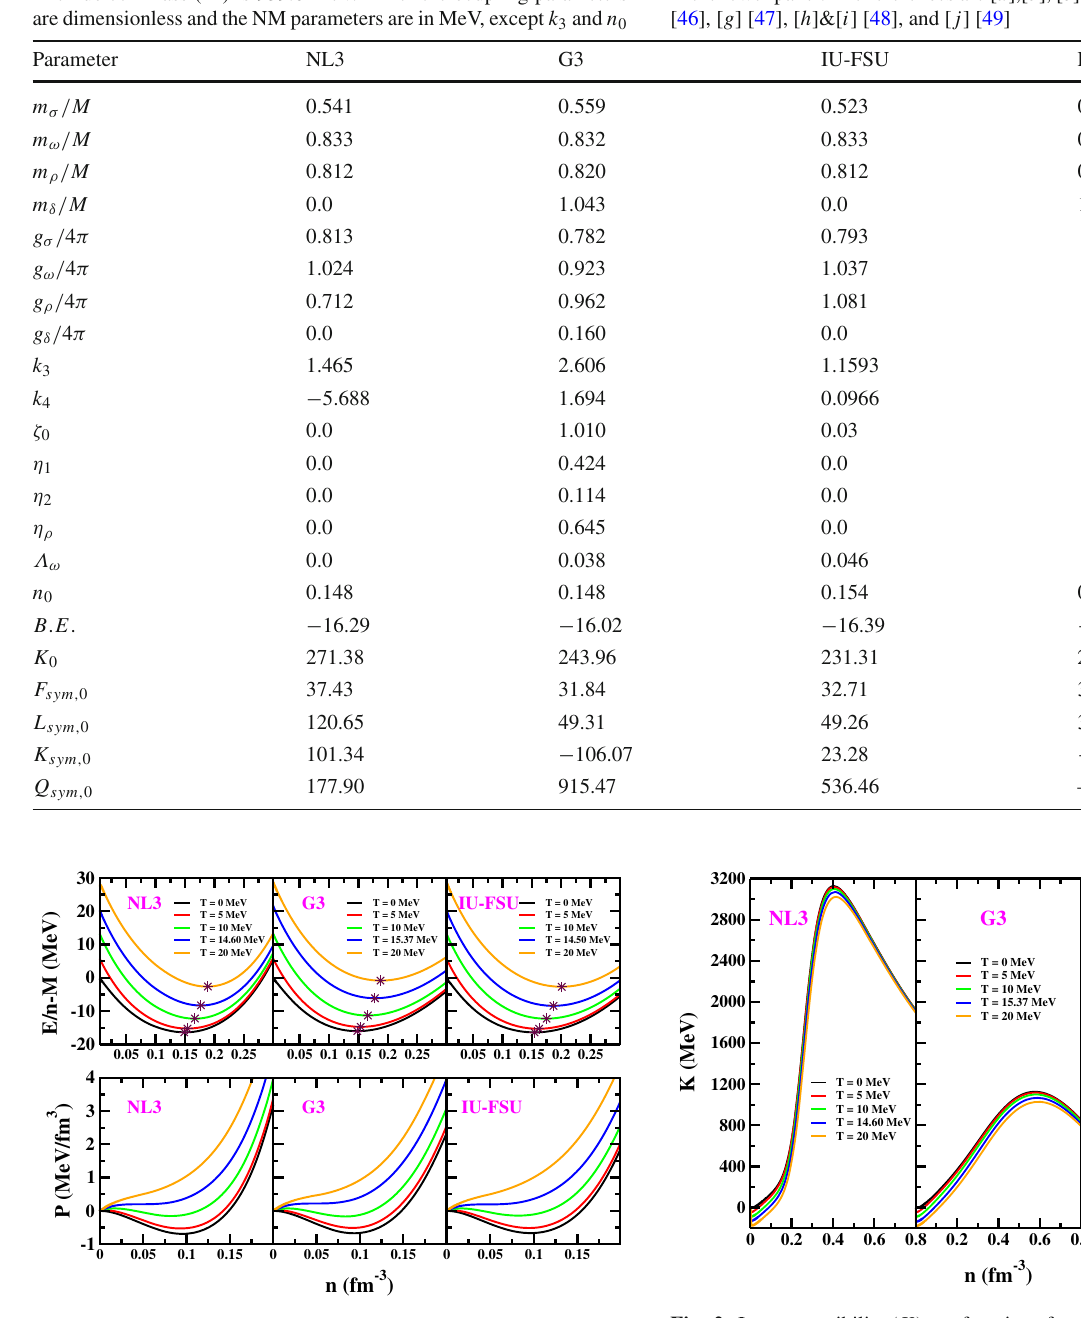
which are in fm − 1 and fm − 3 respectively. The NM parameters are given at saturation point and T = 0 K for NL3, G3 and IU-FSU parameter sets in the lower panel. The references are [ a ] , [ b ] , [ c ] and [ d ] [45], [ e ] & [ f ]